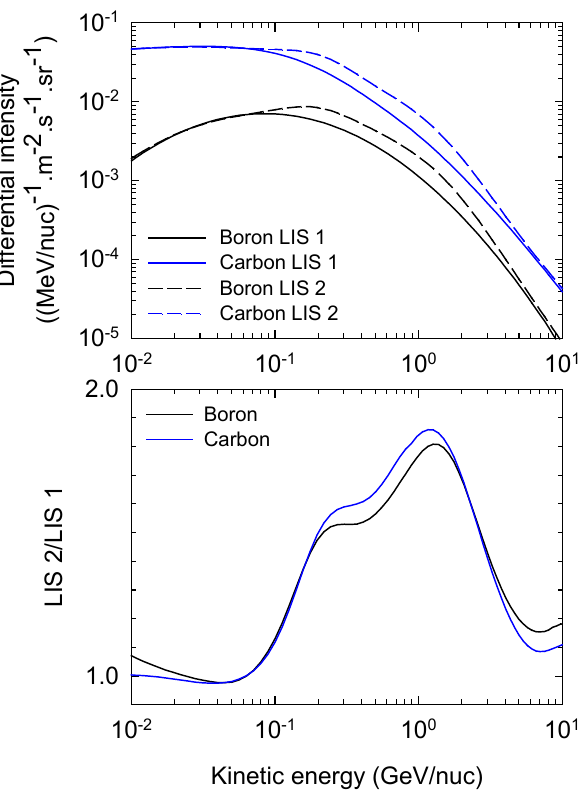
Fig. 7. A comparison of the two sets of interstellar spectra for B and C as used in this study; lower values (LIS1; solid lines) by Moskalenko et al. (2002), higher values (LIS2-dashed lines) by Moskalenko et al. (2003). The latter contains a local interstellar contribution to spectra of primary nuclei as proposed by Moskalenko et al. (2003) and is probably closer to what can be considered a local IS for carbon. In the lower panel the corresponding ratios (LIS2/LIS1) are shown as a function of energy/nuc.